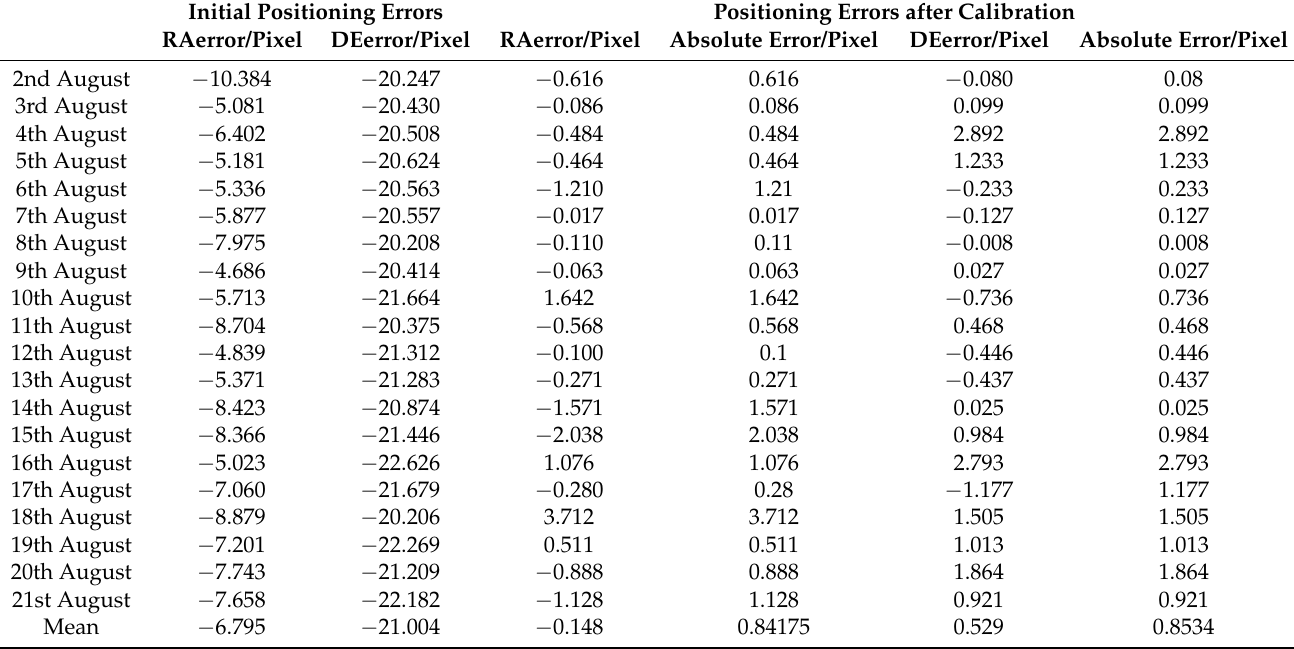
Table 3. Positioning errors before and after